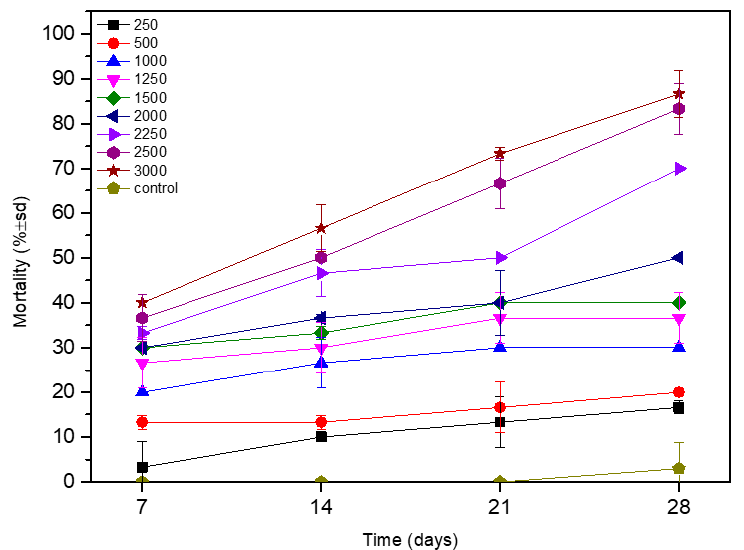
Figure 4. Mean mortality (% ± SD) of R. domenica adults sprayed with six concentrations of cyantraniliprole after 28 days.